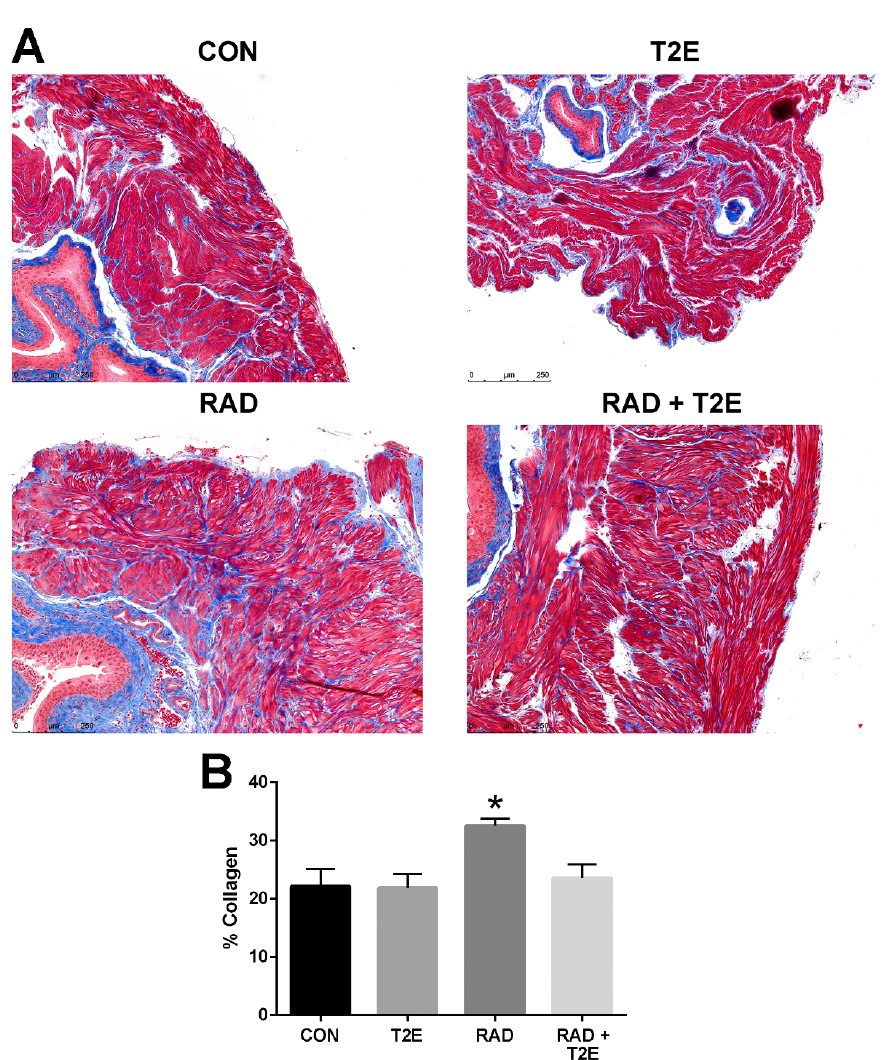
Figure 7. MnTE-2-PyP treatment inhibits fibrosis in bladder tissues at 6 months post-irradiation. ( A ). Representative sections of bladder tissues stained with trichrome to observed collagen deposition from each of the four groups: Control (PBS), MnTE-2-PyP treated alone, Radiation + PBS and Radiation + MnTE-2-PyP. ( B ). The average percent collagen deposition for each group. A 1-way ANOVA followed by post hoc Tukey’s test for multiple comparisons was used to determine differences between groups. The symbol (*) denotes a significant difference as compared to the control group. Magnification bar = 250 µm. There were 5–9 animals/group. Red = cytoplasm, muscle, keratin. Blue = collagen. Black = nuclei.